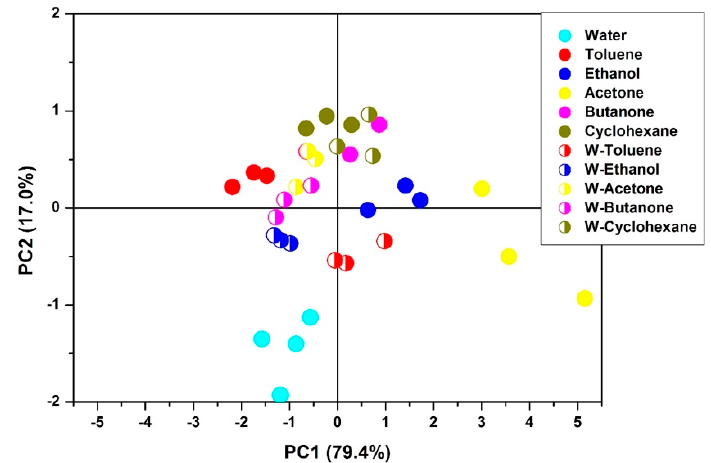
Figure 9. PCA mapping for 100 ppm of VOC (solid circles in front of solvent name) and mixes of 100 ppm VOC with 100 ppm H 2 O (semi-solid circles of the same colour with W in front of the name of the solvent).